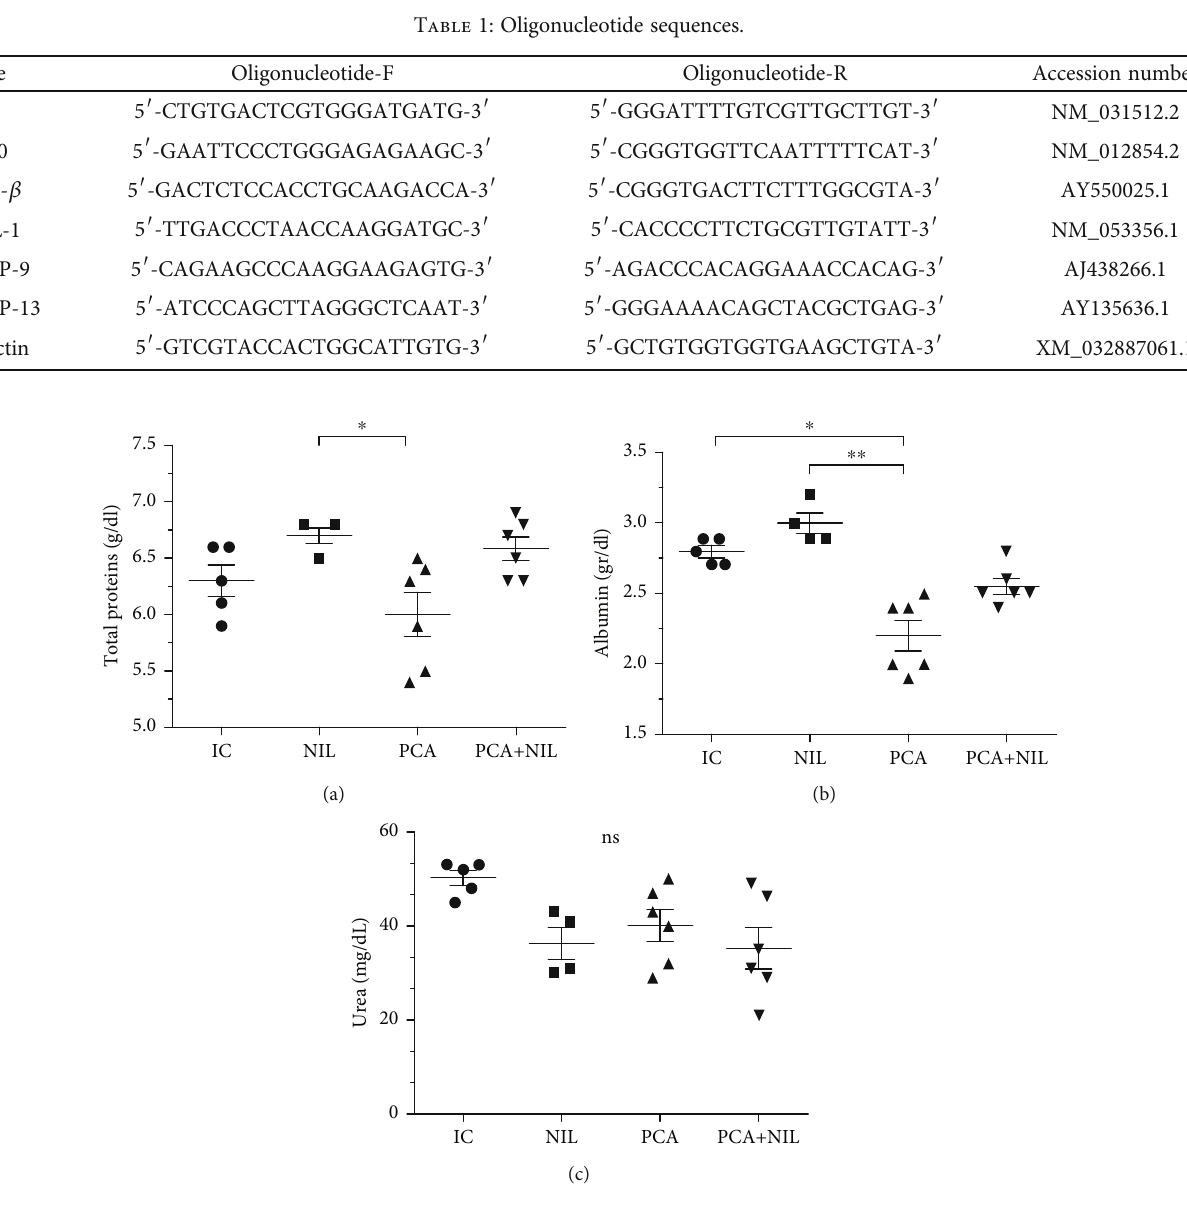
Figure 2: E ff ects of neurointermediate pituitary lobectomy (NIL), portacaval anastomosis (PCA), and PCA+NIL on total proteins (a), albumin (b), and urea (c) serum levels. The intact control (IC) group served as reference. (a) ∗ p < 0 : 05 : NIL vs. PCA+NIL. (b) ∗ p < 0 : 05 : IC vs. PCA and ∗∗ p < 0 : 01 NIL vs. PCA. (c) Nonstatistical (NS) di ff erences between groups were observed. It was evaluated with analysis of variance test with the Tukey post hoc values, which are expressed as the mean ± SD